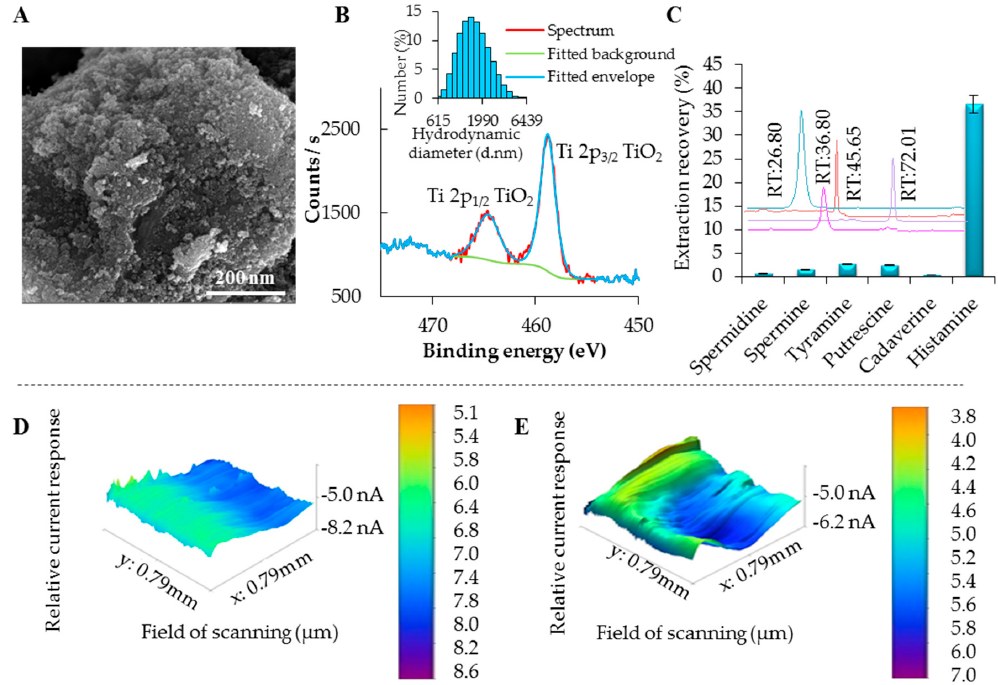
Figure 3. Basic characterization of prepared PMPs. ( A ) Micrograph, expressing microparticles surface and morphology, the length of scale bar is 200 nm; ( B ) XPS narrow scan of Ti2p of MAN18; ( C ) Binding specificity of the prepared particles after application of 100 µg·mL − 1 of selected Bas. Chromatograms showing various retention times of BAs immobilized on PMPs, with expression of their peak area representing the amount specifically bound on PMPs. Scanning electrochemical microscopy 3D images characterizing the PMP electrochemical surface changes after binding of Him, relative current response of PMP surface: ( D ) for blank PMPs without Him bound to their surface and ( E ) for PMPs after binding of Him.